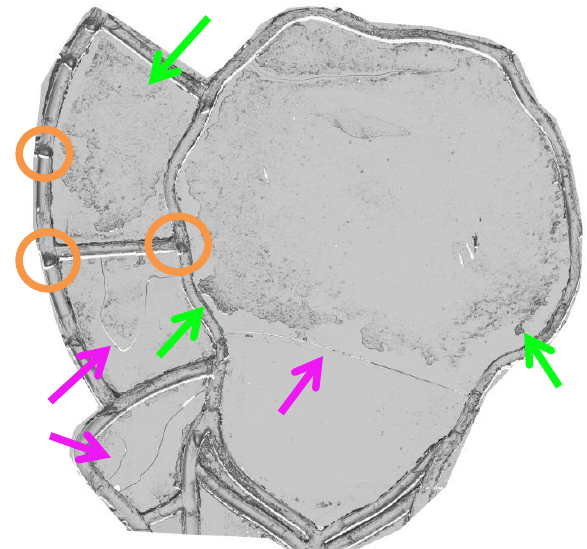
Figure 12. Detail of window 2b from Oswiecim (outside). Orange: The solder drops caused strong heat; Green: the thin lime slurry; pink: craqueled glass